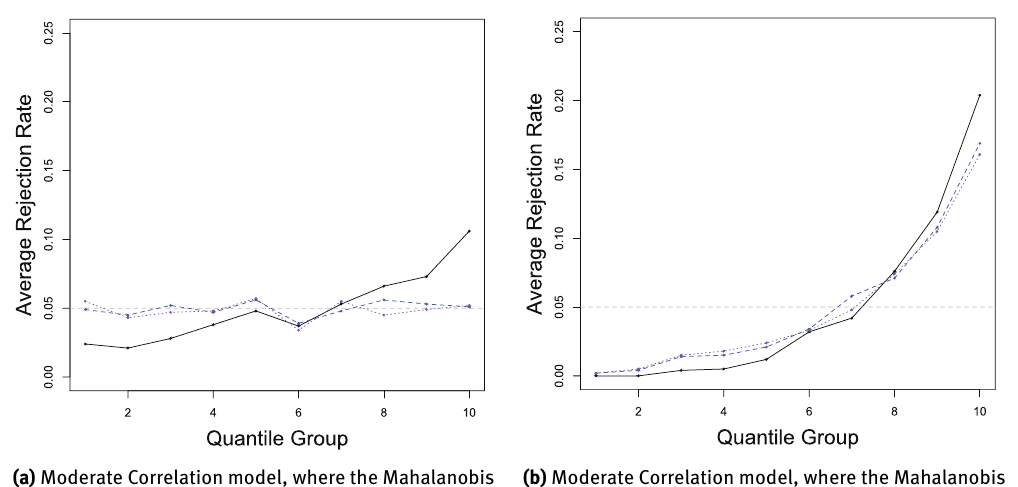
, X , X 2 , X ) and ( √ | X | 2 4 1 3